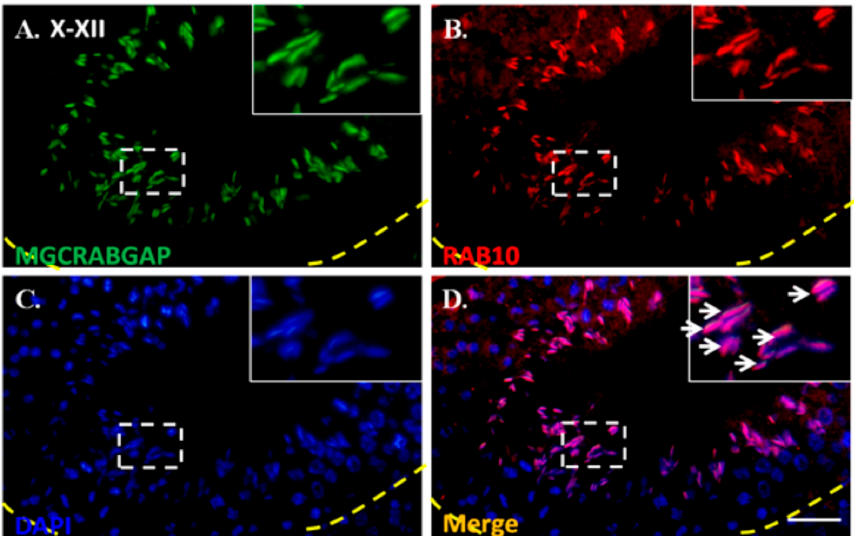
Figure 4. Colocalization of MGCRABGAP and RAB10 in murine testicular sections; Colocalization of MGCRABGAP with RAB10 in adult murine testicular sections; ( A – D ), anti-MGCRABGAP antibody (green); anti-RAB10 antibody (red); 4 ′ ,6-diamidino–2-phenylindole (DAPI) (blue); merging of MGCRABGAP, RAB10, and DAPI; The enlarged figure is shown in the right upper corner. The arrow indicates the co-staining signals of MGCRABGAP, RAB10, and DAPI. Scale bar: 20 μ m.